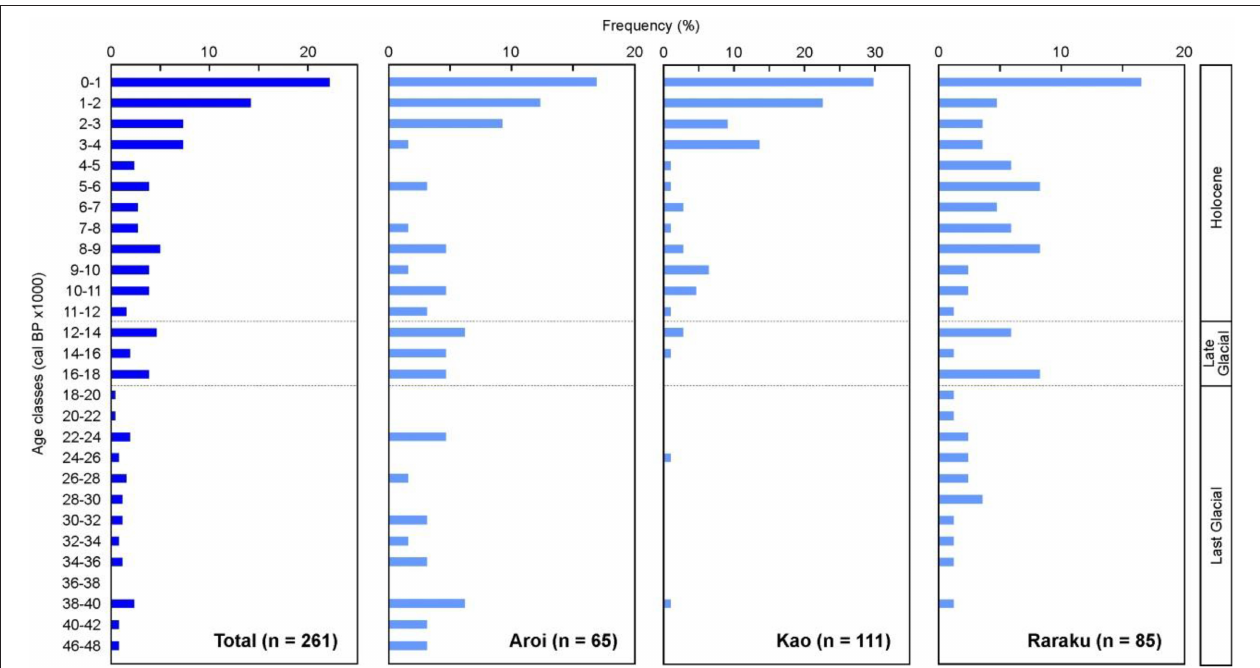
FIGURE 2 | Histogram with the distribution of radiocarbon ages by time intervals. Only calibrated ages (median probability) have been considered. Raw data in the Supplementary